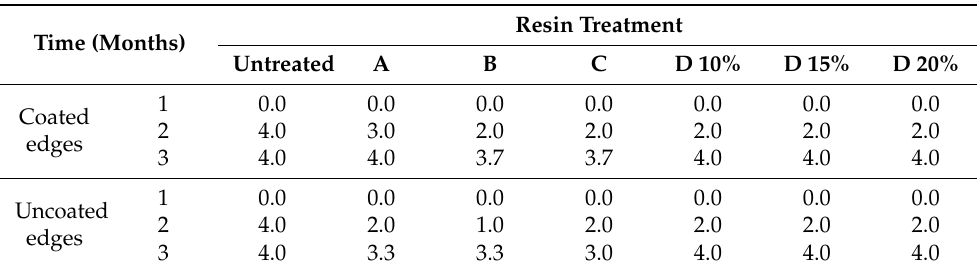
Table 4. Mould and blue stain growth marks on PF resin treated plywood in outdoor, aboveground conditions tested according to EN 152:2011